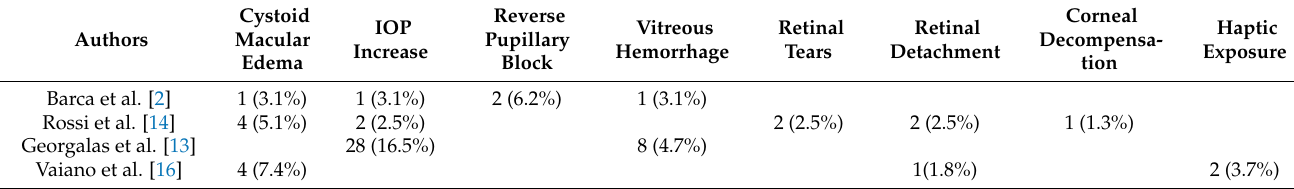
Table 2. Complications rates in the analyzed publications.